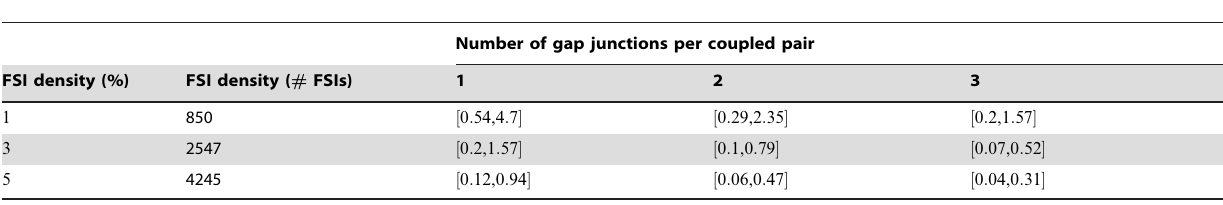
Number of gap junctions per coupled pair